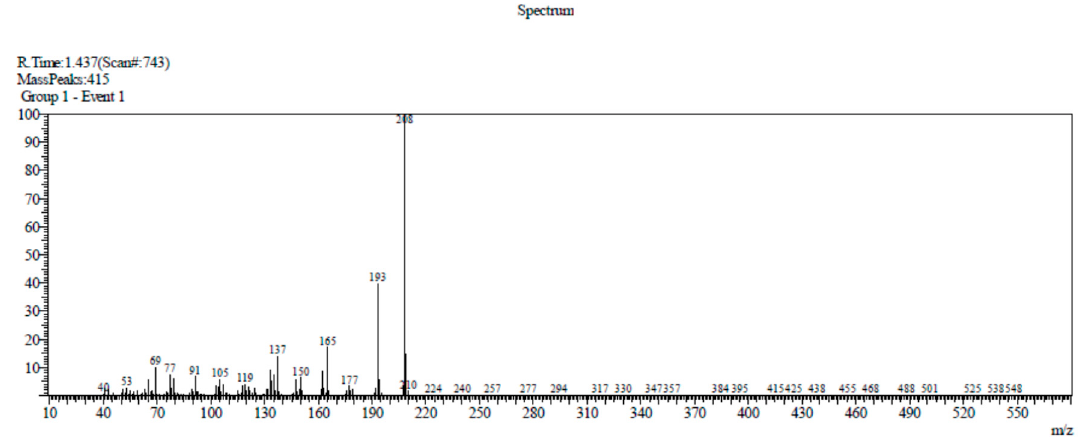
Figure 2. Direct injection probe mass spectrometer (DIP-MS) spectrum of β -asarone.